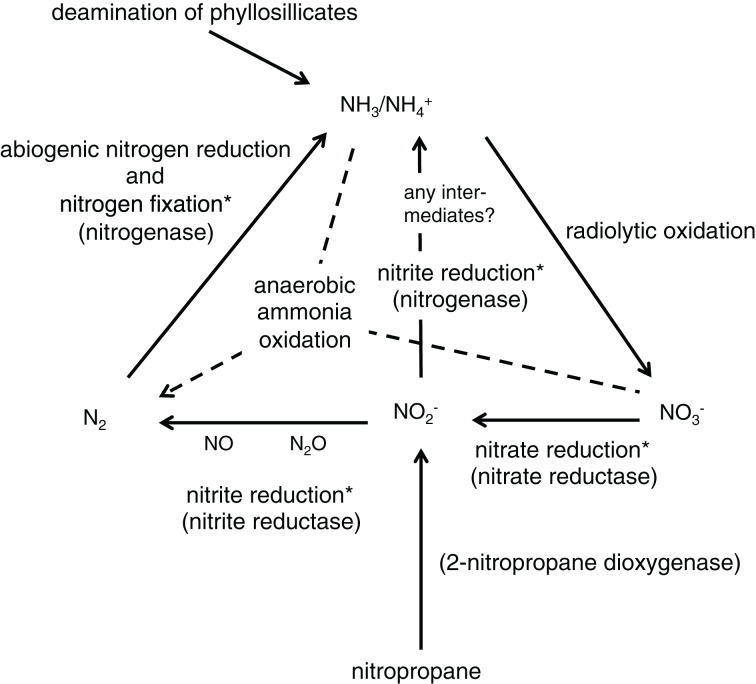
Schematic diagram of the proposed N cycle in deep terrestrial subsurface sites in South Africa. Solid lines indicate processes suggested by molecular (this study) and geochemistry analyses (Silver et al., 2012). Dashed lines indicate processes that are known in the global N cycle but their occurrence in deep terrestrial subsurface sites is yet to be proven. Asterisks denote microbially mediated processes.